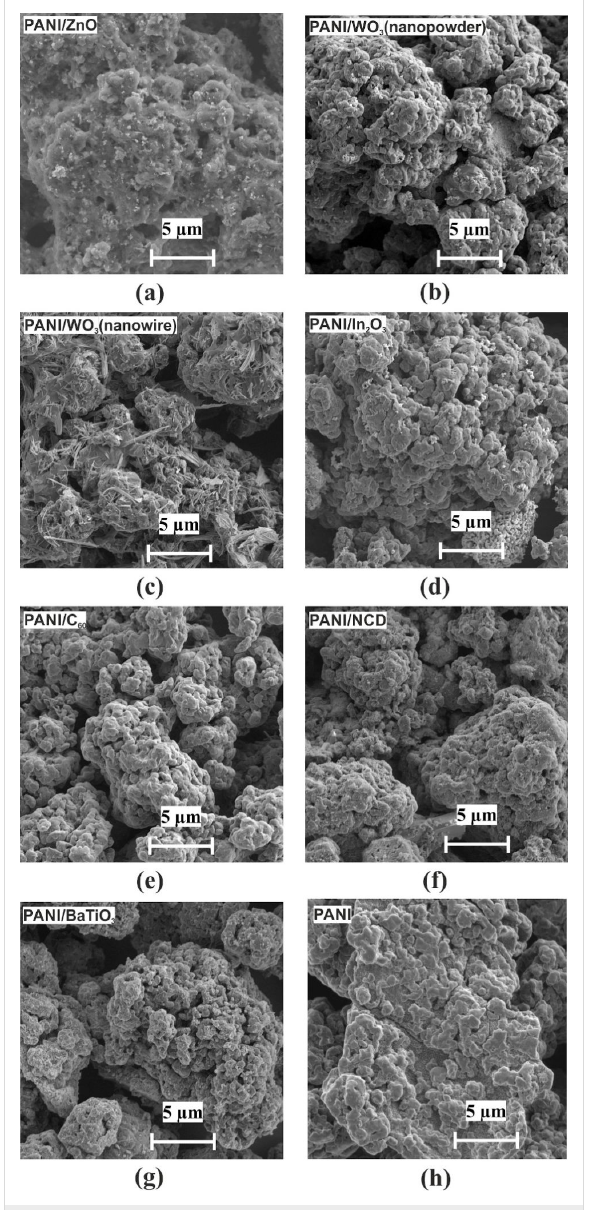
Figure 1: SEM micrographs of deposited layers on an interdigital transducer structure: (a) PANI/ZnO, (b) PANI/WO 3 (nanopowder), (c) PANI/WO 3 (nanowire), (d) PANI/In 2 O 3 , (e) PANI/C 60 , (f) PANI/ NCD, (g) PANI/BaTiO 3 , and (h) pristine